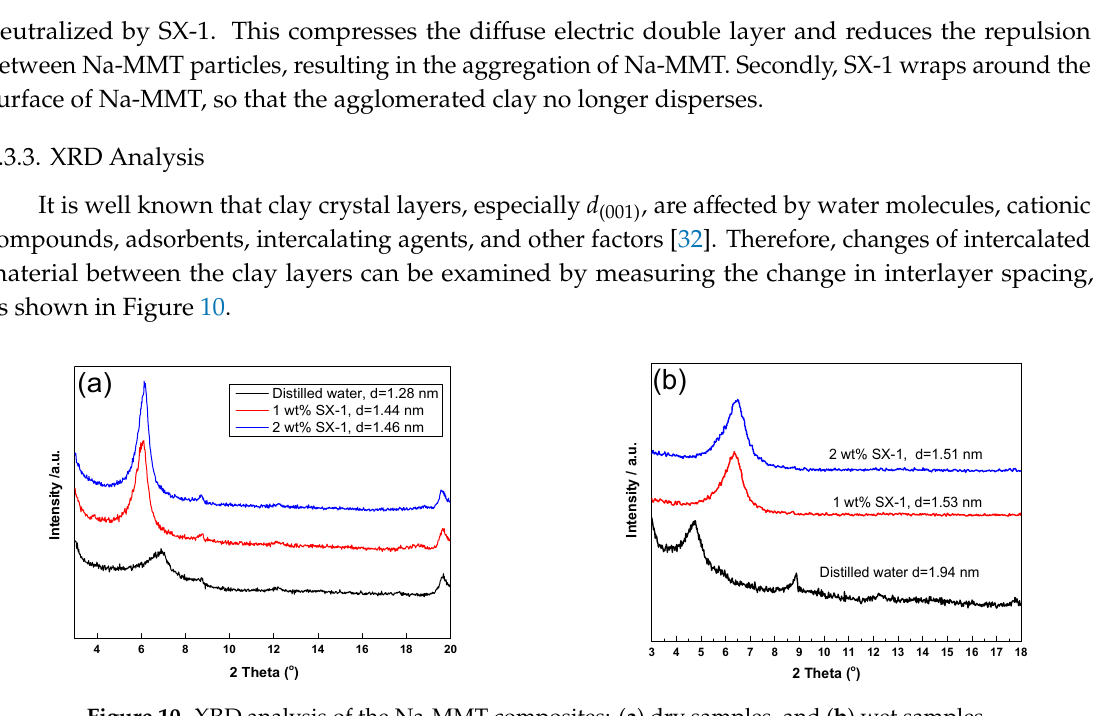
Figure 10. XRD analysis of the Na-MMT composites: ( a ) dry samples, and ( b ) wet samples.